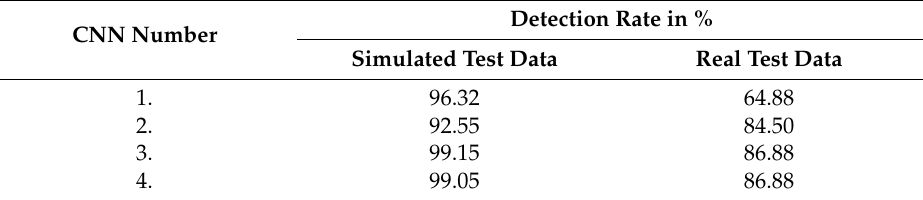
Table 2. Comparison of the classification performance of the different CNN architectures.